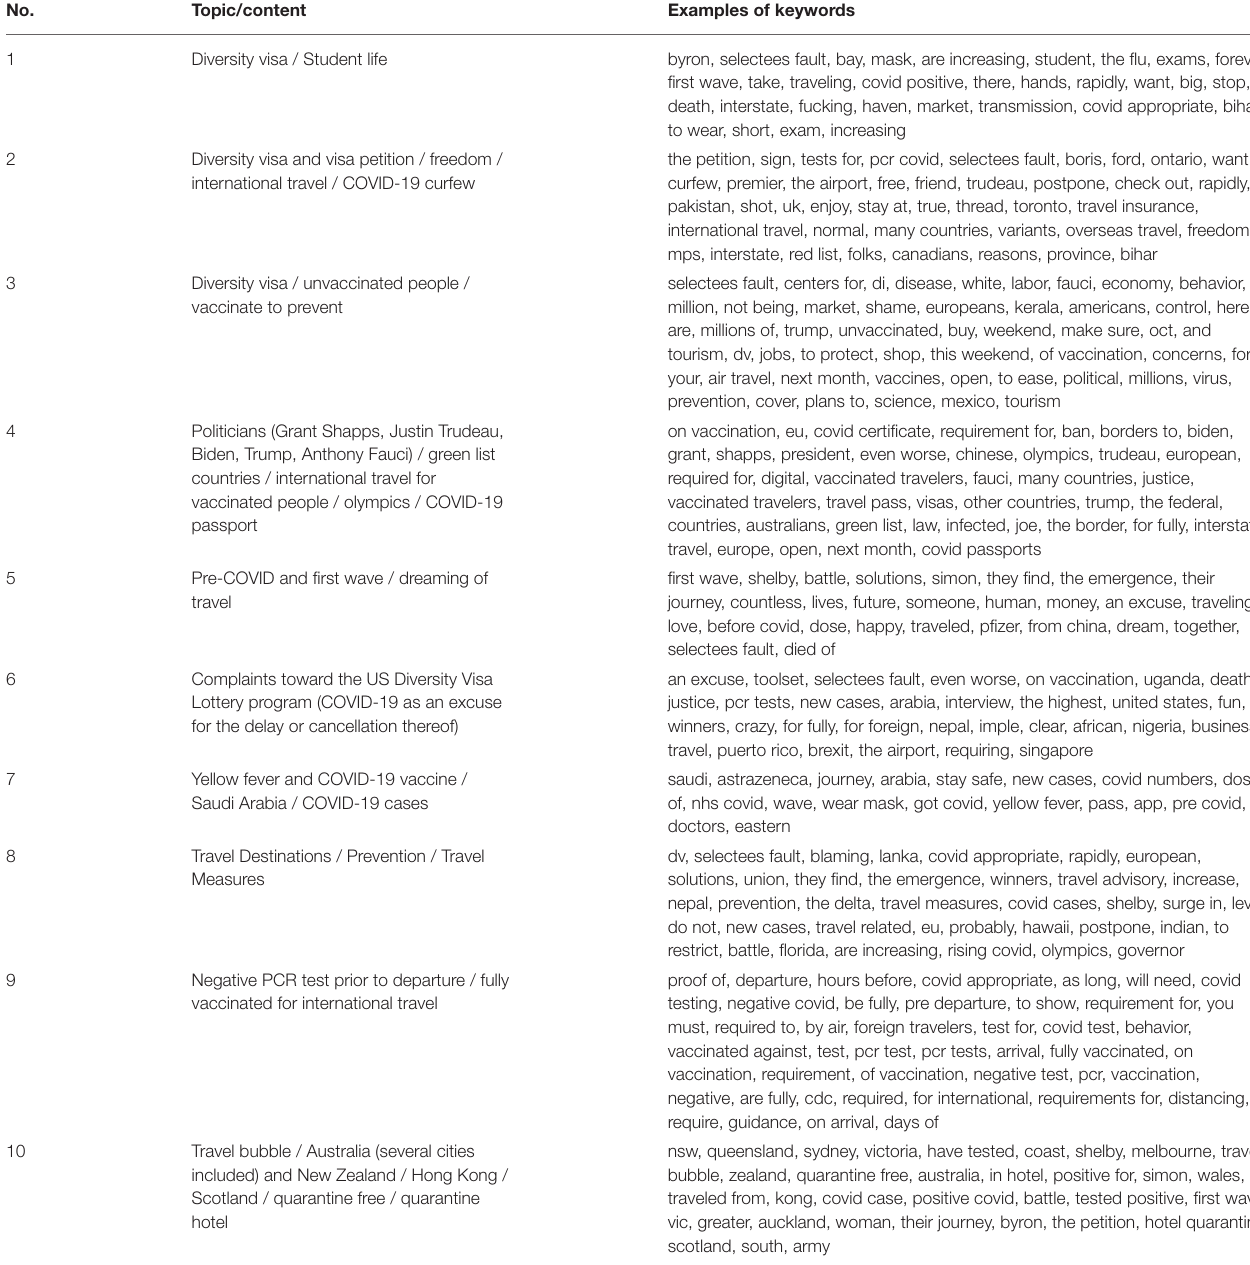
TABLE 4 | Hierarchical topic reduction of